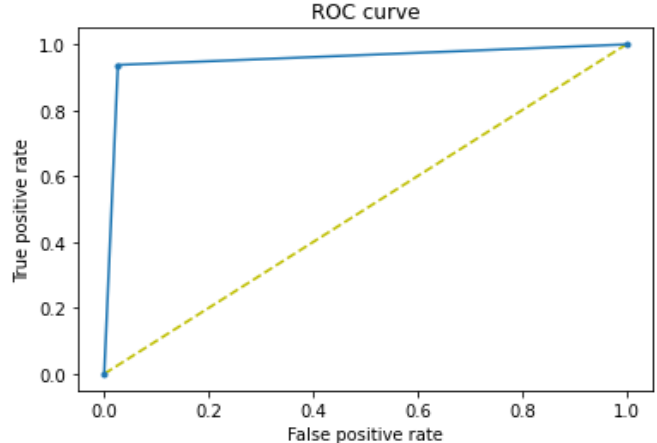
Figure 7. ROC curve of proposed model.